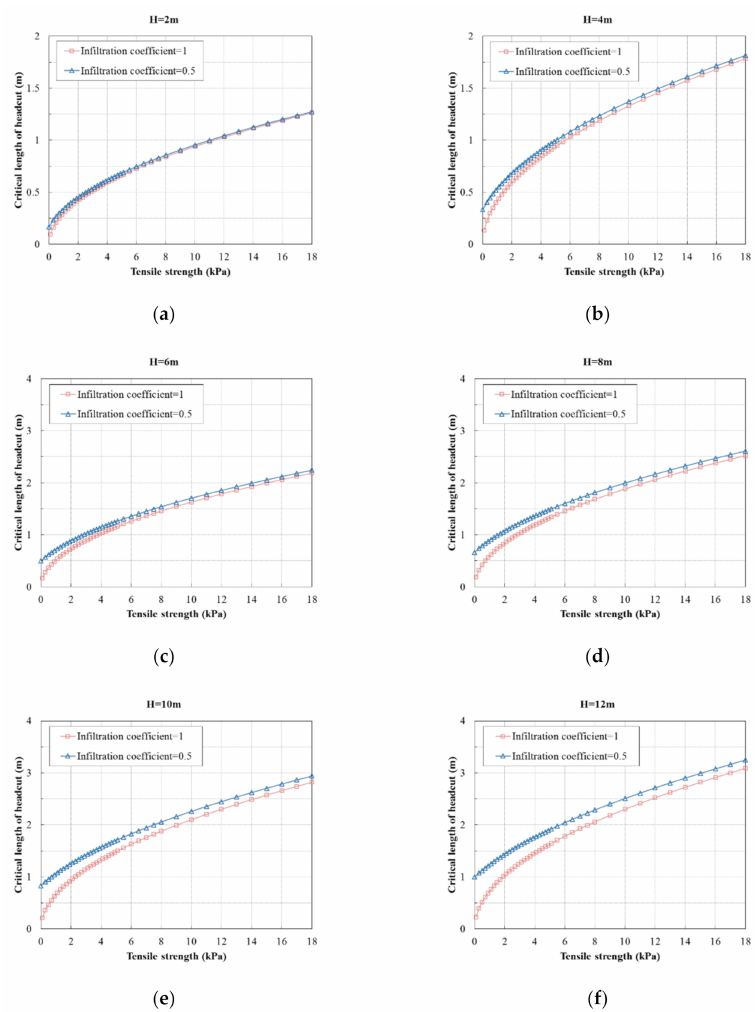
Figure 6. Comparisons of the critical lengths of the headcuts under two extreme soil infiltration situations ( β i = 1 and β i = 0.5 ). ( a ) Embankment height H = 2 m. ( b ) Embankment height H = 4 m. ( c ) Embankment height H = 6 m. ( d ) Embankment height H = 8 m. ( e ) Embankment height H = 10 m. ( f ) Embankment height H = 12